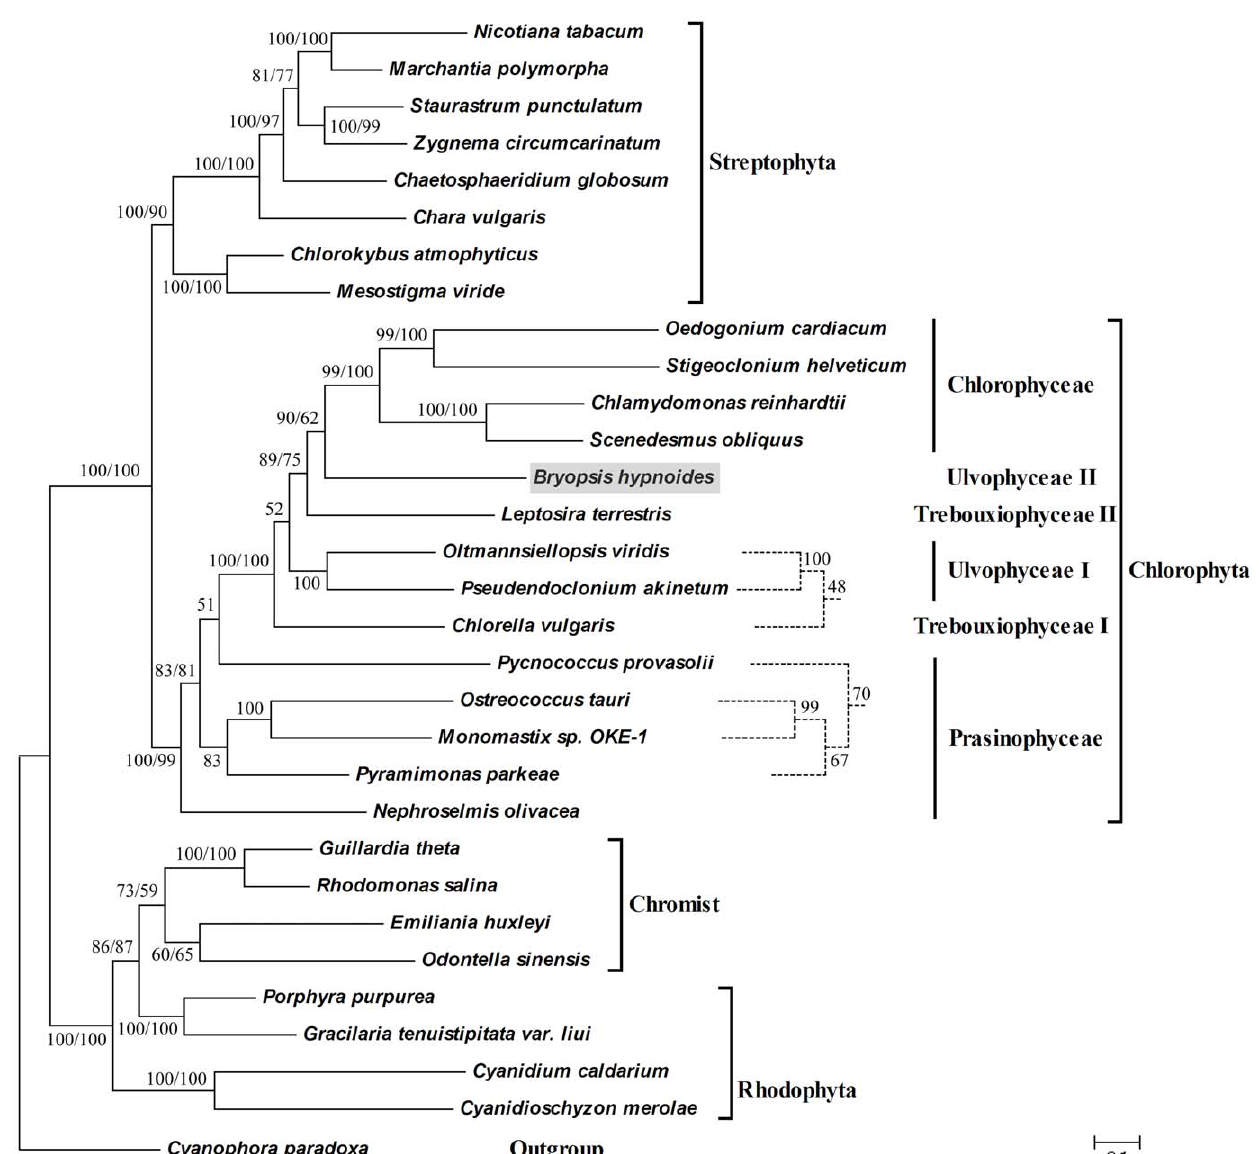
Figure 5. Phylogenetic position of B.hypnoides as inferred by ML analyses of 42 cpDNA-encoded proteins. Family-level affinities are shown on the right of the diagram. Cyanophora paradoxa were used as outgroup. Numbers in each branch indicated maximum-likelihood (ML) / maximum parsimony (MP) bootstrap values; and the dashed lines indicated the MP topologies which were different from the ML tree.